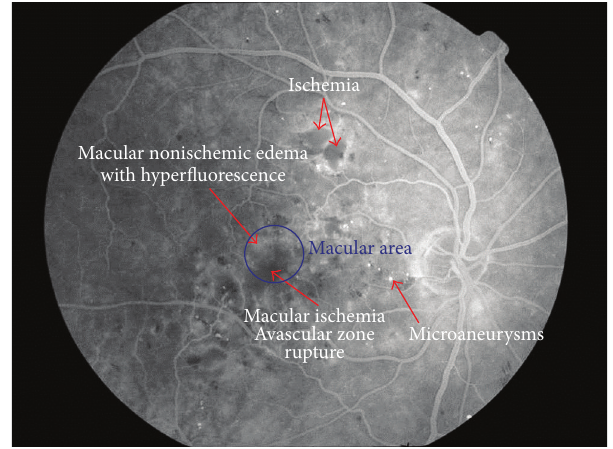
Figure 8: Fluorescein angiography of a patient with severe diabetic retinopathy and macular ischemia. We observe the rupture of avascular zone by ischemia and also hyperfluorescence area in macula at temporal